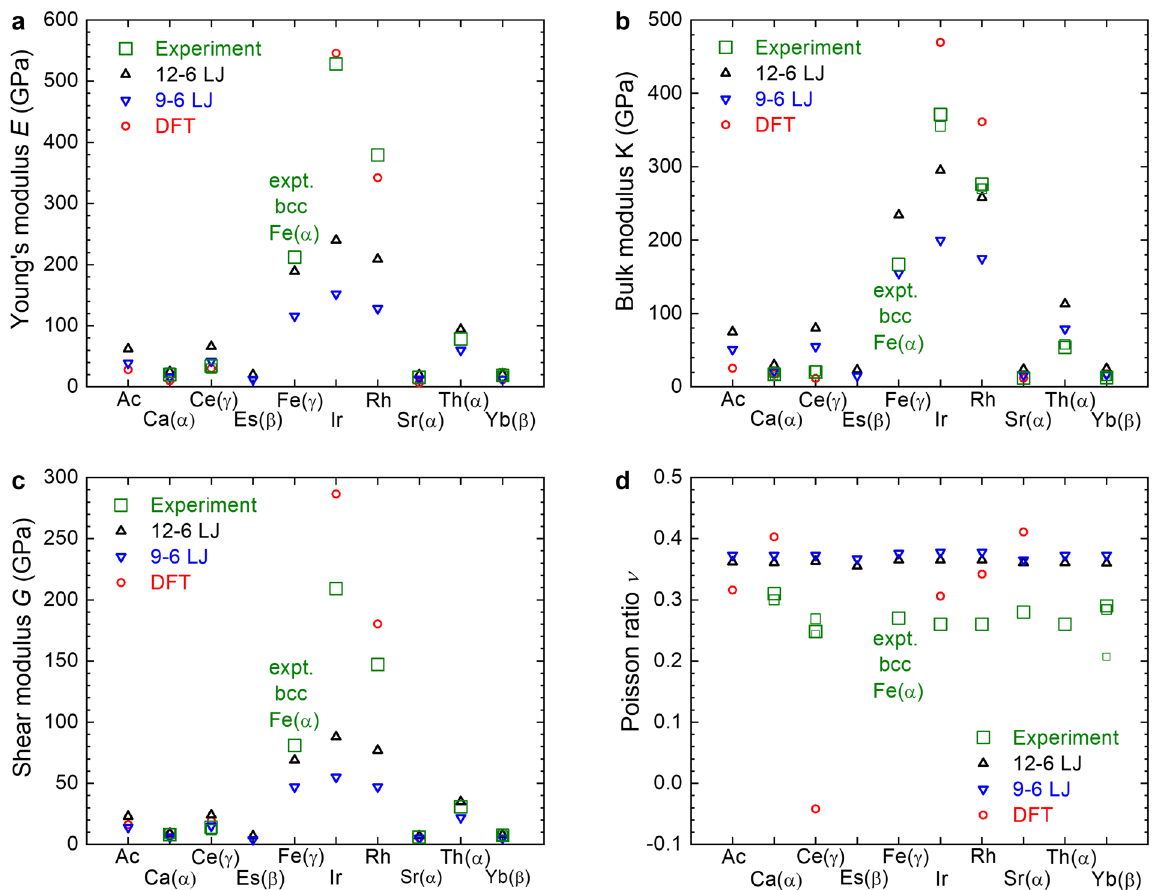
Fig. 3 Mechanical properties of the fcc metals. Data from the experiment, computation with the LJ models, and DFT are shown (with the RBPE functional where possible). a Young ’ s modulus, b bulk modulus, c shear modulus, d Poisson ratios. Deviations of computed values from experiment are signi fi cant and tend to be lower with the 12-6 LJ